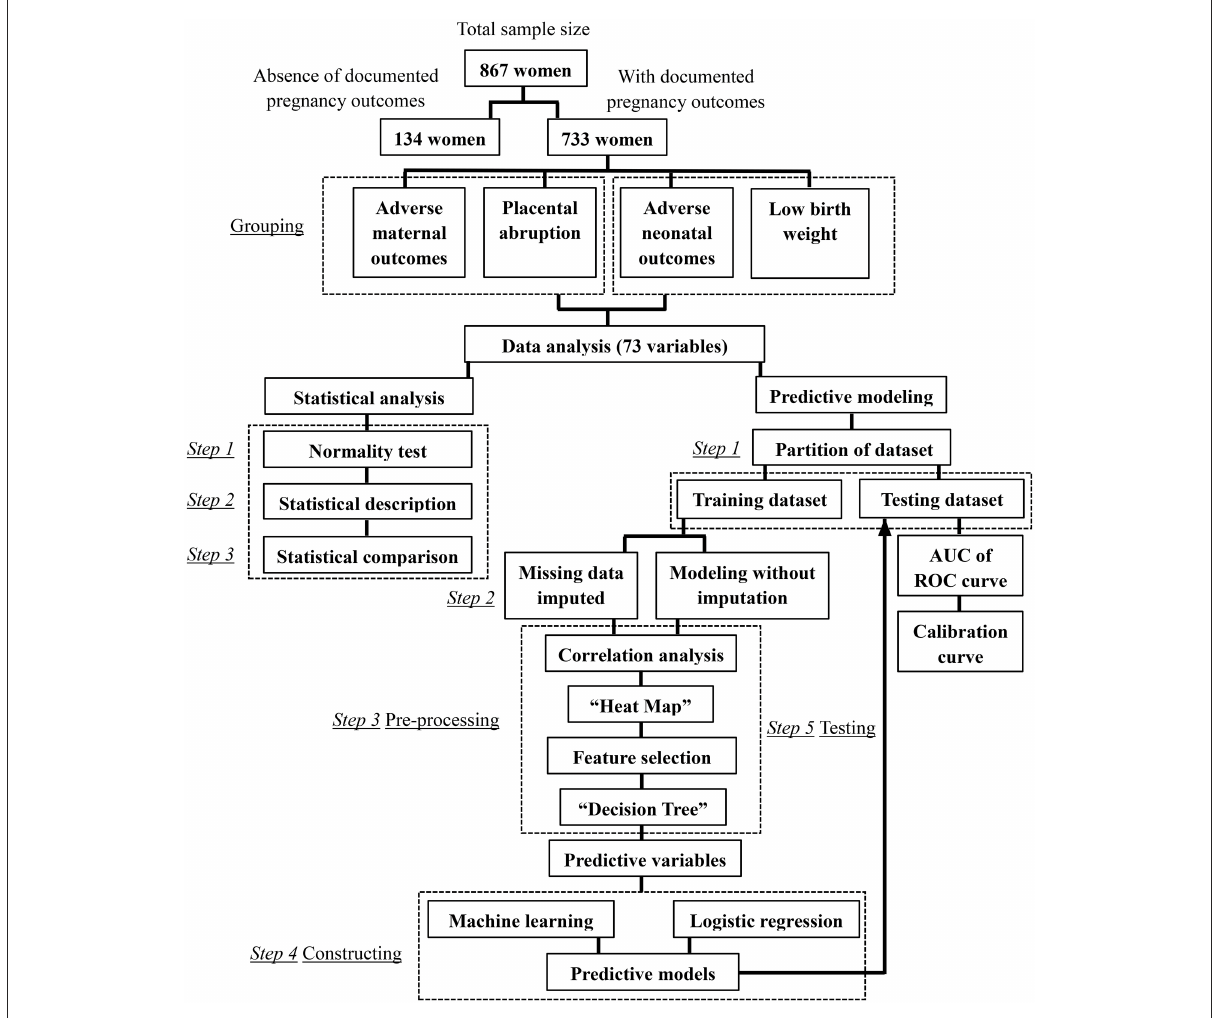
FIGURE1 The flowchart of this